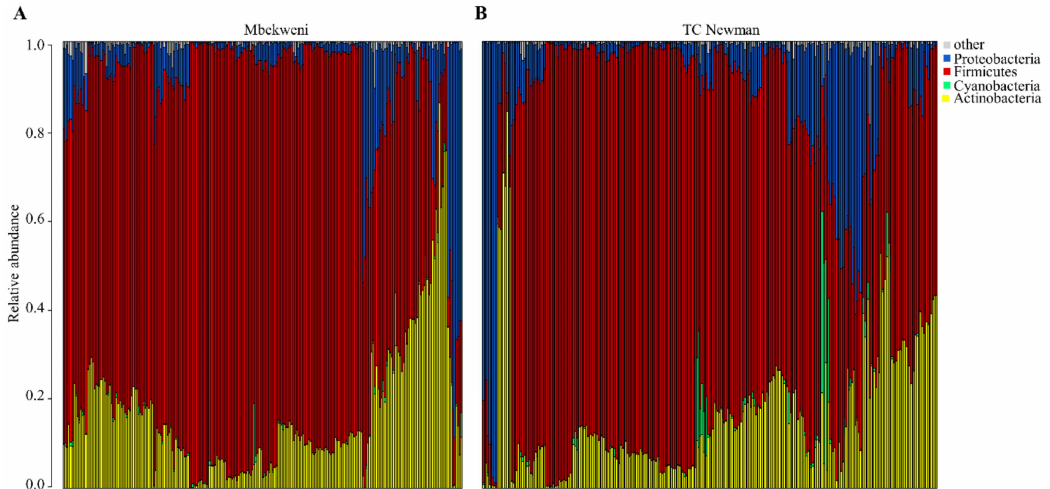
Figure 1. Complete linkage unsupervised hierarchical clustering of relative abundances of human breast milk (HBM) bacterial phyla. Bar-plot of relative abundances of HBM bacteria genera at ( A ) Mbekweni and ( B ) TC Newman study sites. Each bar represents a mother’s HBM bacteriome profile and each colored box, a bacterial phylum. Phyla with less than 0.5% abundance in a given sample are grouped together, herein referred to as “other” (grey